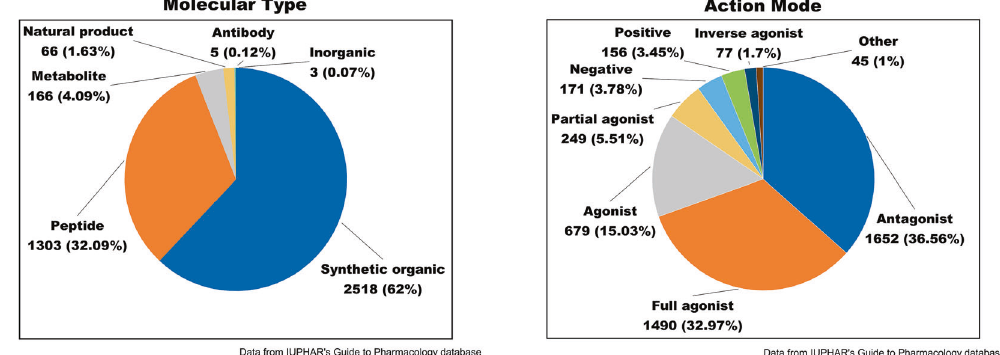
Fig. 2 Analysis on agents targeting GPCRs. Distribution of molecule type (left) and action mode (right). Positive, PAM; Negative,